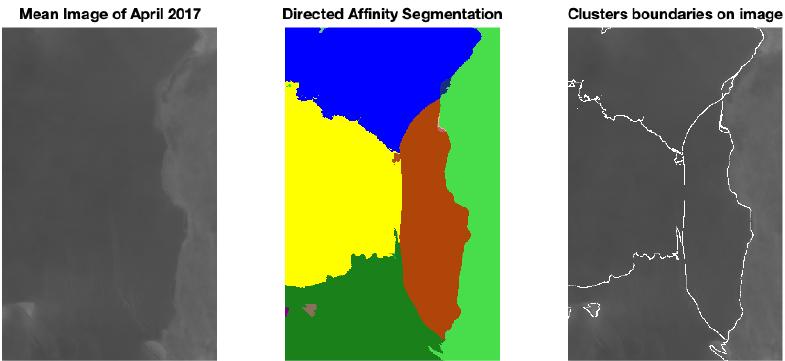
Figure B7. The mean image and the directed affinity partitioning as of April 2017. Raw images sourced from Scambos et al. (1996).